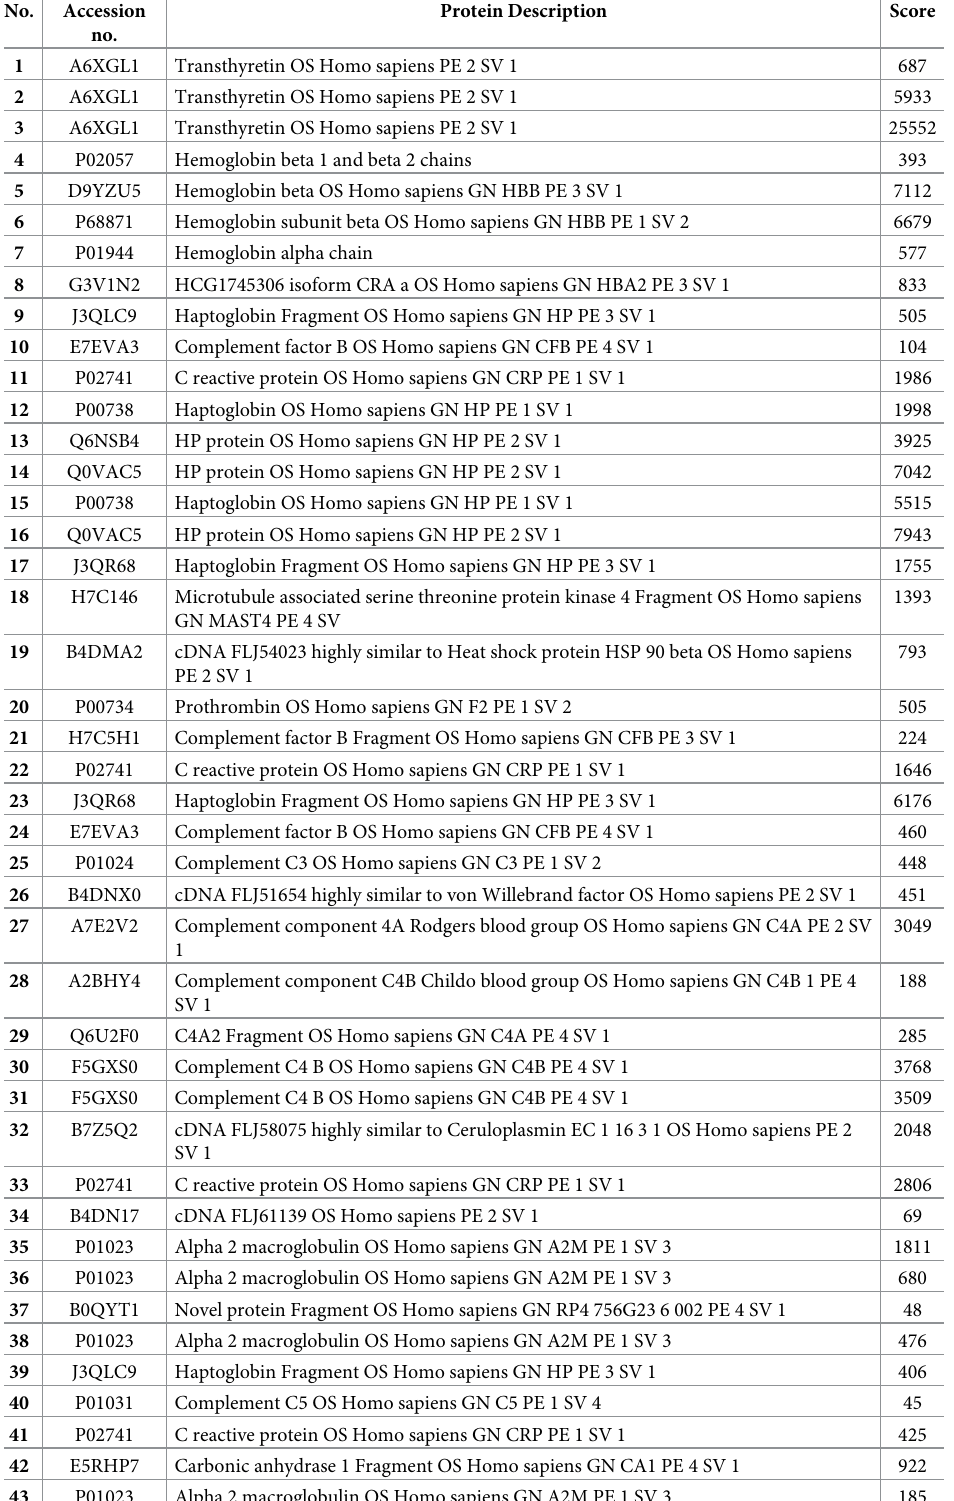
Table 2. Identification of spots which signals changed substantially over